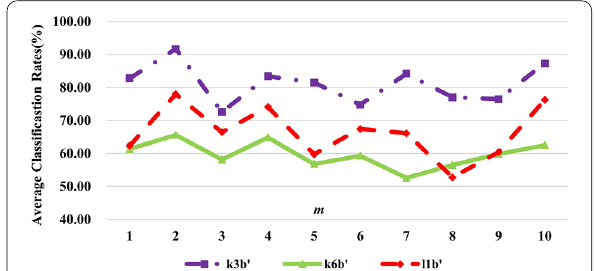
Fig. 7 Effects of different m values on the classification results in α + β band for each subject